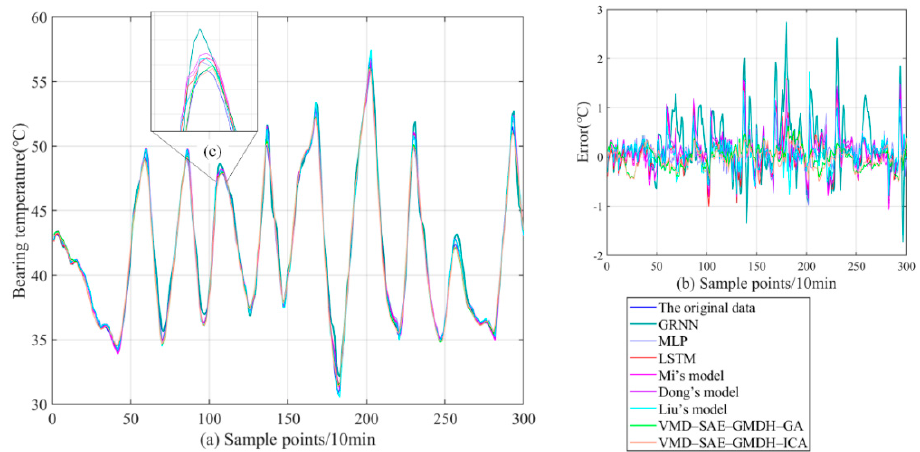
Figure 7. Forecasting results and errors of all models of series #3: ( a ) forecasting results; ( b ) error distribution; ( c ) local